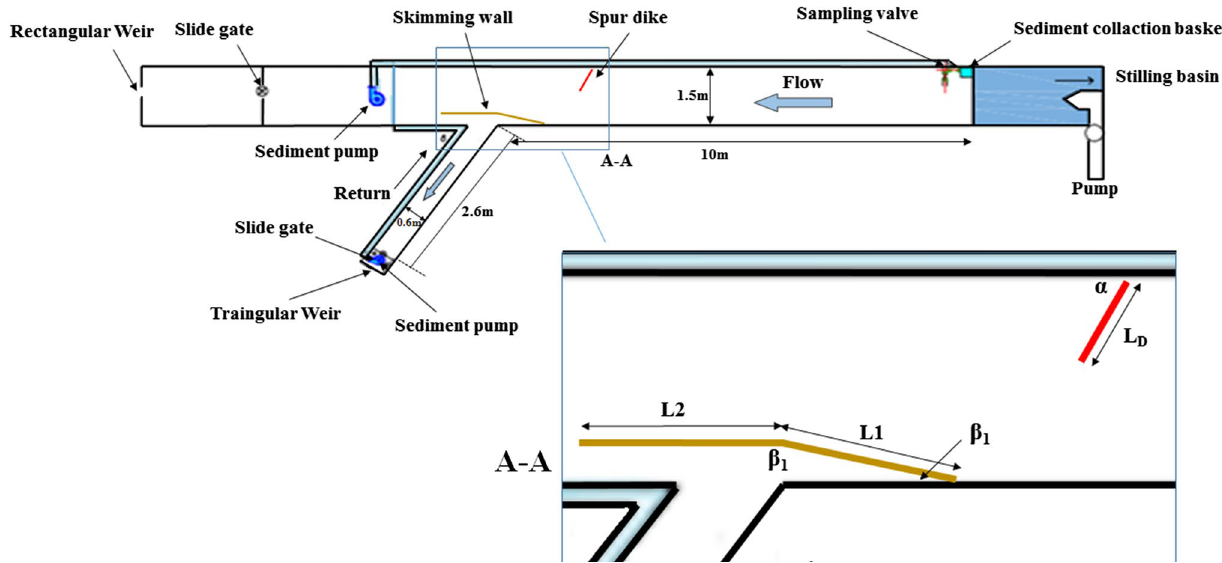
Fig. 2 A schematic view of the flume, spur dike, skimming wall and water circulation system and sediment bed